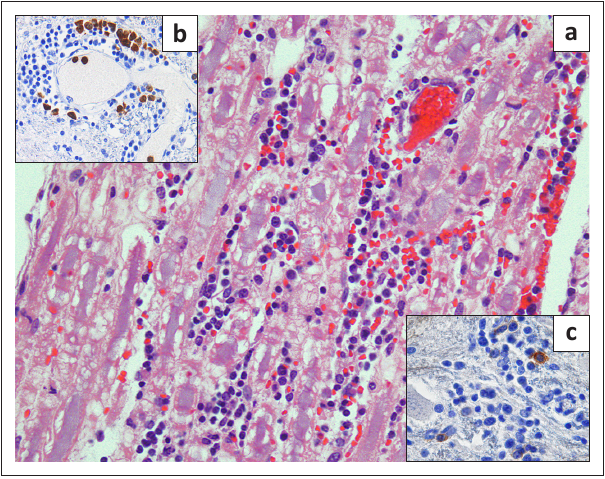
FIGURE 4: (a) Lumbar spinal cord of lineage 2 West Nile virus Case 3 with unilateral ventral horn focal poliomalacia, neurone necrosis and perivascular mononuclear cuffing. (b) Case 3 lumbar spinal cord white matter vessel with many immunohistochemistry cluster of differentiation 20+ (brown cytoplasm) B-lymphocytes or plasma cells amongst the perivascular mononuclear infiltrate. Cluster of differentiation 20 immunoperoxidase using LSAB+ DAB as chromogen and haematoxylin counterstain x 400. (c) Case 3 lumbar spinal cord ventral horn grey matter vessel with perivascular and scattered immunohistochemistry cluster of differentiation 3+ (brown) T-lymphocytes. cluster of differentiation 3 immunoperoxidase using LASB+ DAB as chromogen and haematoxylin counterstain x 400.